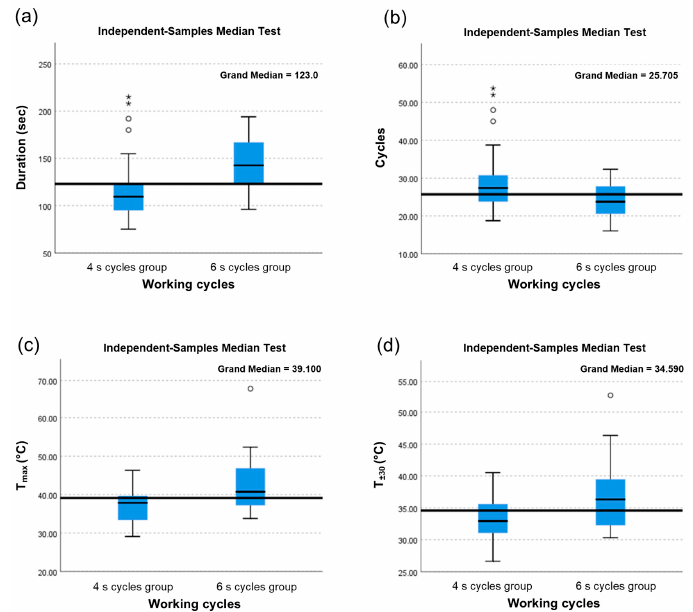
Figure 3. Box plots with median values for each study parameter. ( a ) Duration (s): time necessary to perform each osteotomy to a 10 mm depth; ( b ) Cycles: number of cycles necessary to perform each osteotomy to a 10 mm depth; ( c ) T max (°C): Highest recorded temperature; ( d ) T ±30 (°C): Arithmetic mean of all temperature data points recorded from 30 s before to 30 s after the highest recorded temperature.